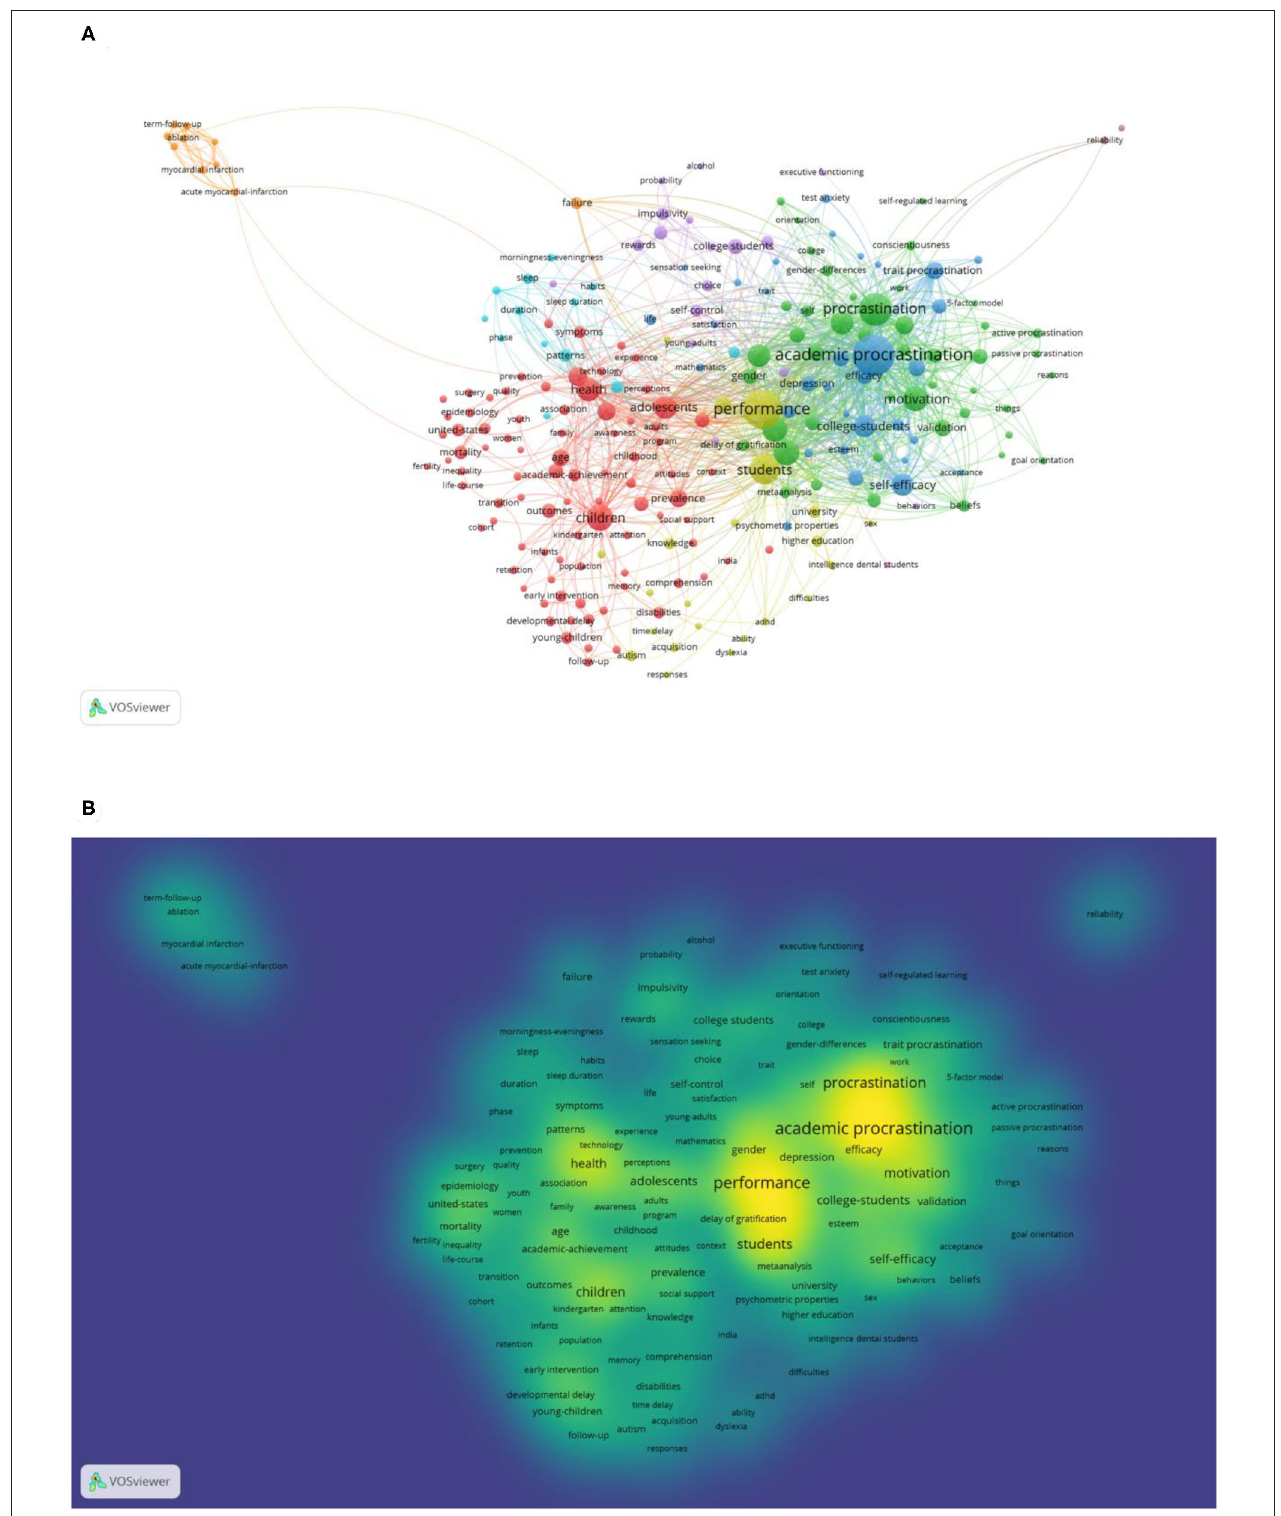
FIGURE 6 | Knowledge domain map of keyword co-occurrence network related to academic procrastination research: (A) network visualization map based on article weights; (B) density visualization map based on article weights.